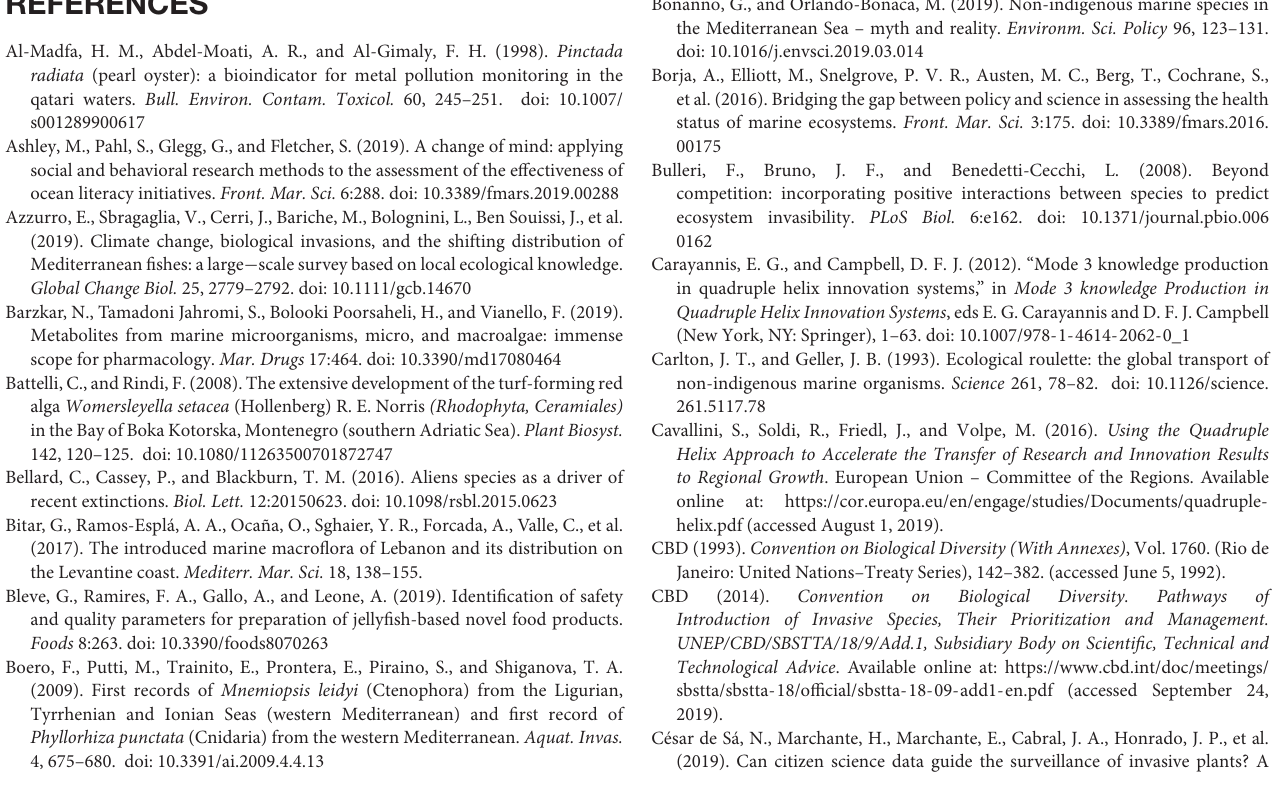
TABLE S1 | Gross domestic expenditure on R&D (GERD) as a percentage of GDP. Data taken from the database available from the UNESCO Institute for